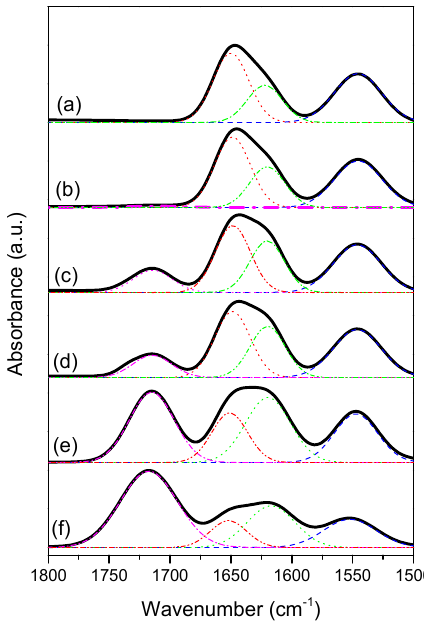
Figure 5. Curving fitting of data from FTIR spectra (dash lines are curve fitting results) of: (a) pure PNIPAAm; (b) PNIPAAm97- co -PAA3; (c) PNIPAAm87- co -PAA13; (d) PNIPAAm80- co -PAA20; (e)